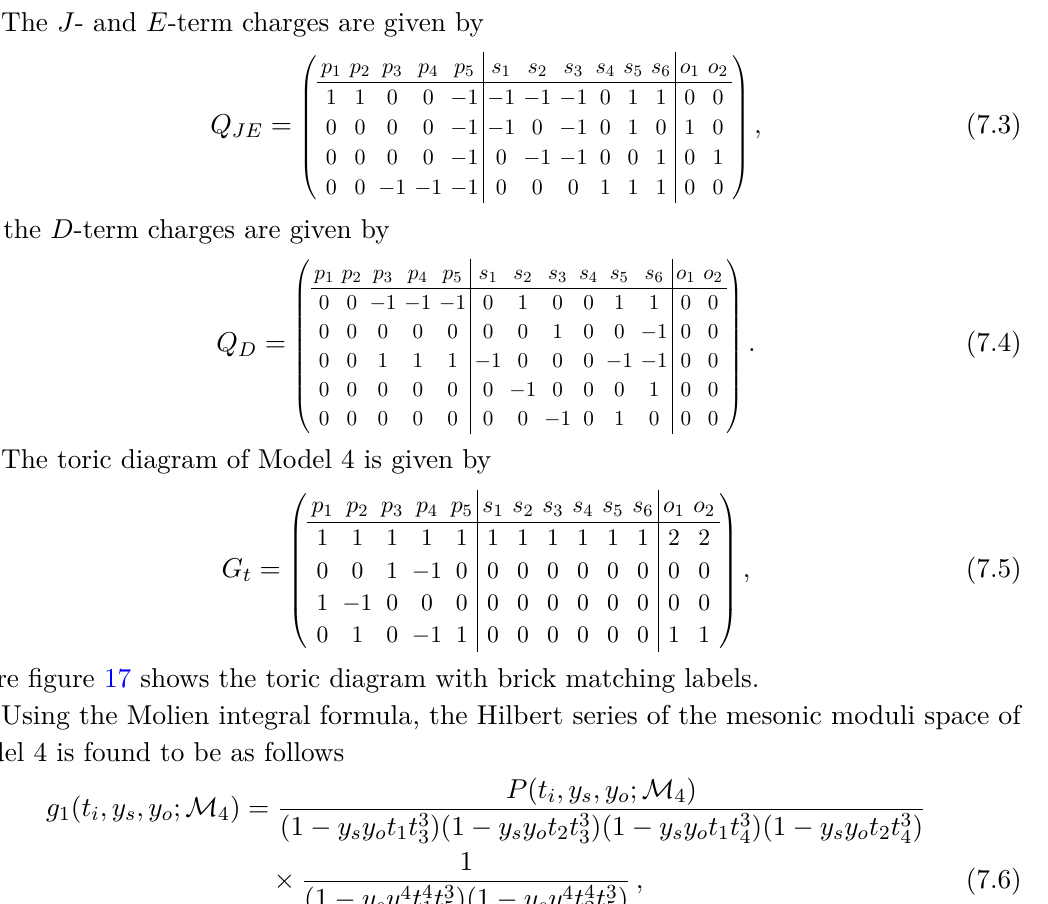
Figure 17 . Toric diagram for Model